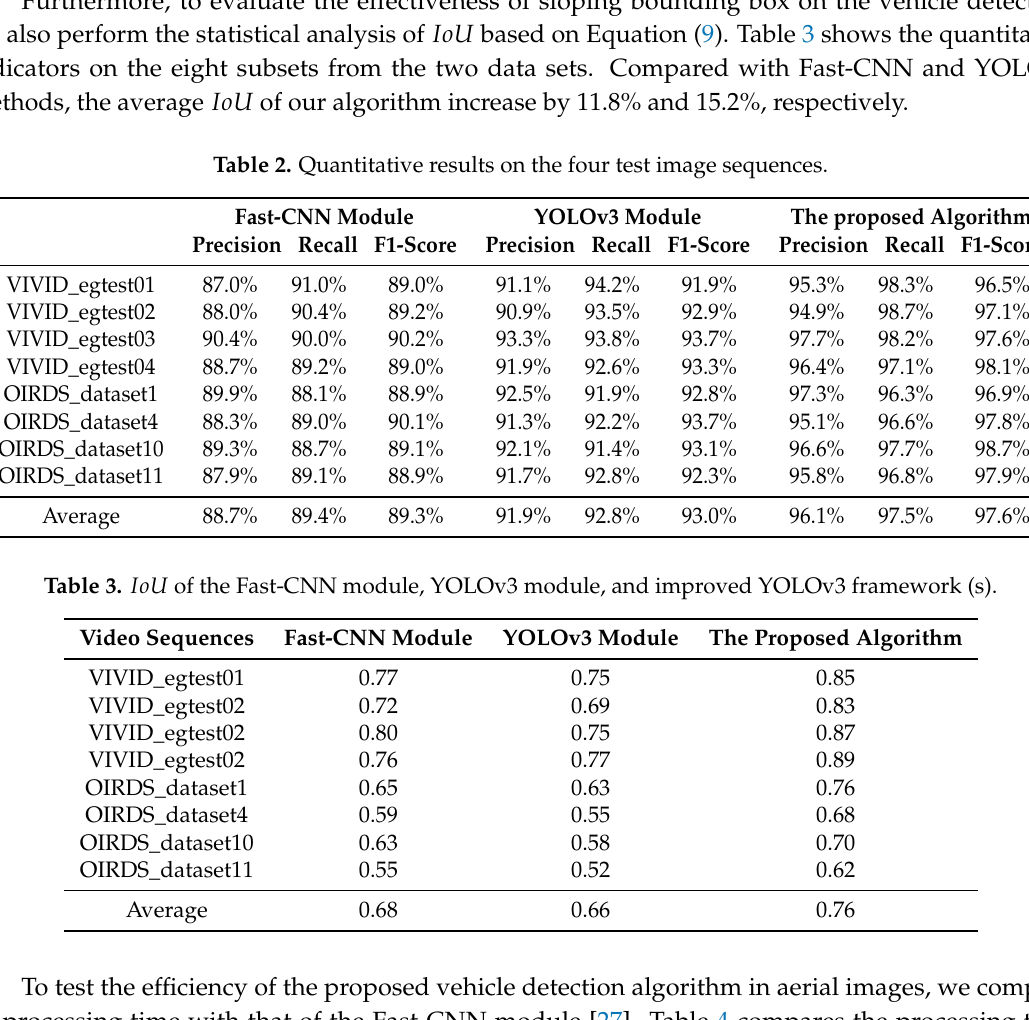
Figure 8p. As a whole, compared with the Fast-CNN module and YOLOv3 network, the